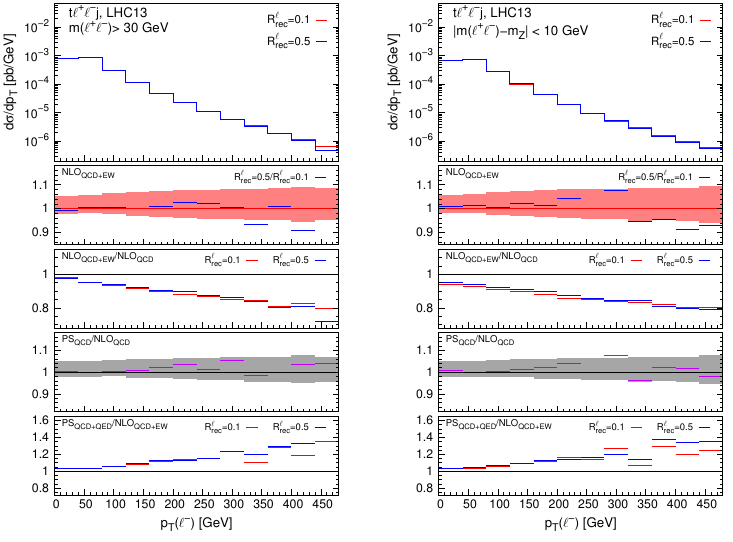
Figure 10 . The p T ( ‘ (cid:0) ) distribution in t‘ + ‘ (cid:0) j production in the \inclusive" (left) and Z -peak (right) range for di(cid:11)erent recombination parameters. The layout of the plots is the same of (cid:12)gure